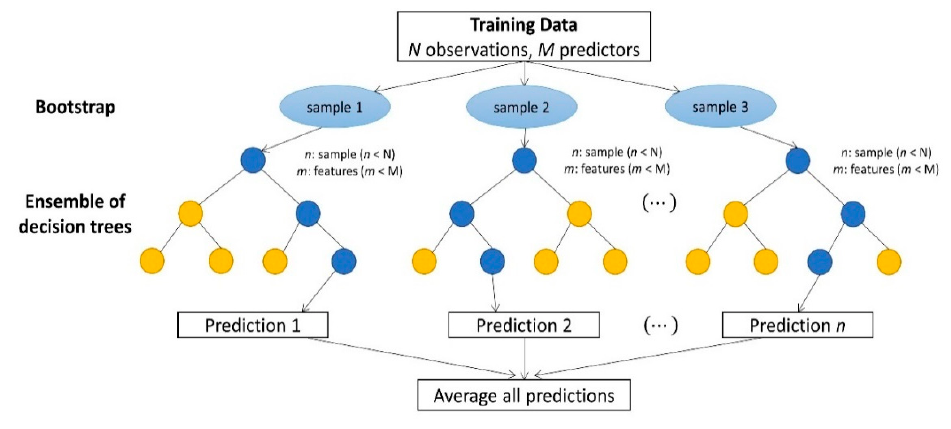
Figure 7. Random Forest method.